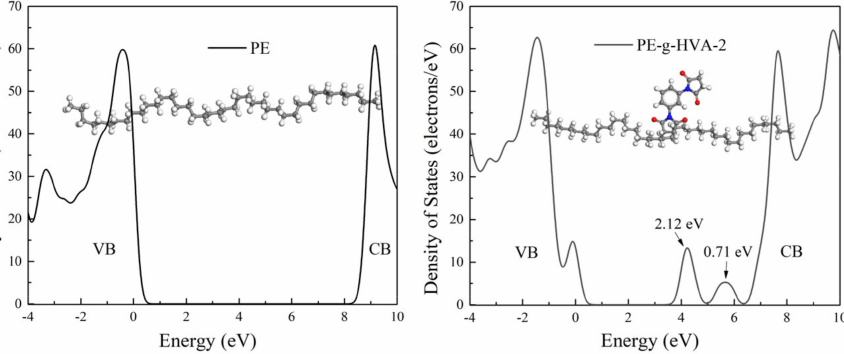
Figure 5. The density of states for PE and HVA-2 grafted PE (CB = conduction band, VB = valence band). The Weibull distributions of DC breakdown strengths of XLPE and HVA-2 grafted XLPE at 25, 50, and 70 ◦ C are represented in Figure 6. DC breakdown strengths of XLPE after HVA-2 grafting modification at 25 and 50 ◦ C reduced significantly, and the break- down strength of the grafted XLPE fell more obviously as the HVA-2 content